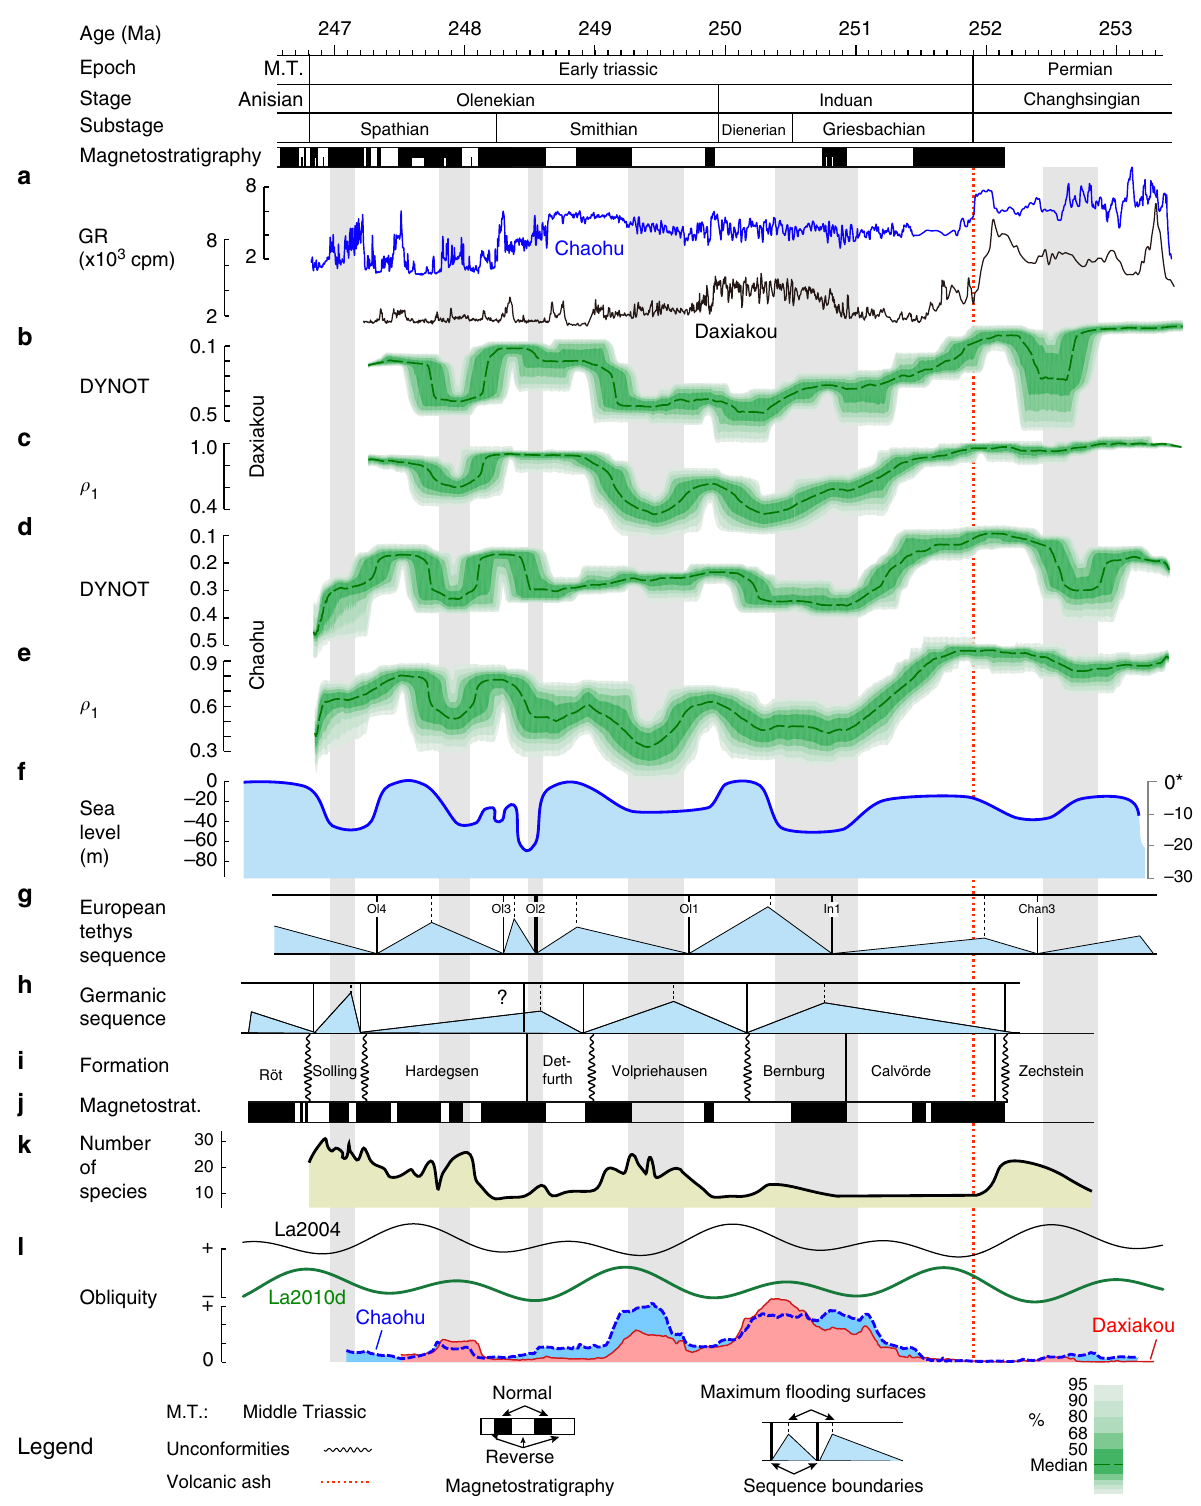
Fig. 6 Global sea level and continental groundwater dynamics during the Early Triassic. Time scale and magnetostratigraphy are from ref.13,14. a GR series at Daxiakou (black) and Chaohu (blue) are from ref.13. cpm: counts per minute. b , c DYNOT and ρ 1 models of the GR series at Daxiakou. d , e DYNOT and ρ ρ 1 models of the GR series at Chaohu. The DYNOT and 1 models were estimated using a running window of 400 kyr (see Supplementary Tab. 1 for sample rates for each spectrum). Con fi dence levels were estimated by a Monte Carlo analysis with 5000 iterations. f , g Sequence and sea-level variations of the European Tethys 7,9 (*Supplementary Note 2 and Supplementary Fig. 13 for details). h – j Lithology, magnetostratigraphy, sequences in the continental Germanic Basin 13,40 (Fig. 5 for details). k Spores and pollen diversity in Pakistan 47 . l Earth ’ s obliquity forcing intensity of La2004 19 , La2010d 49 and in South China